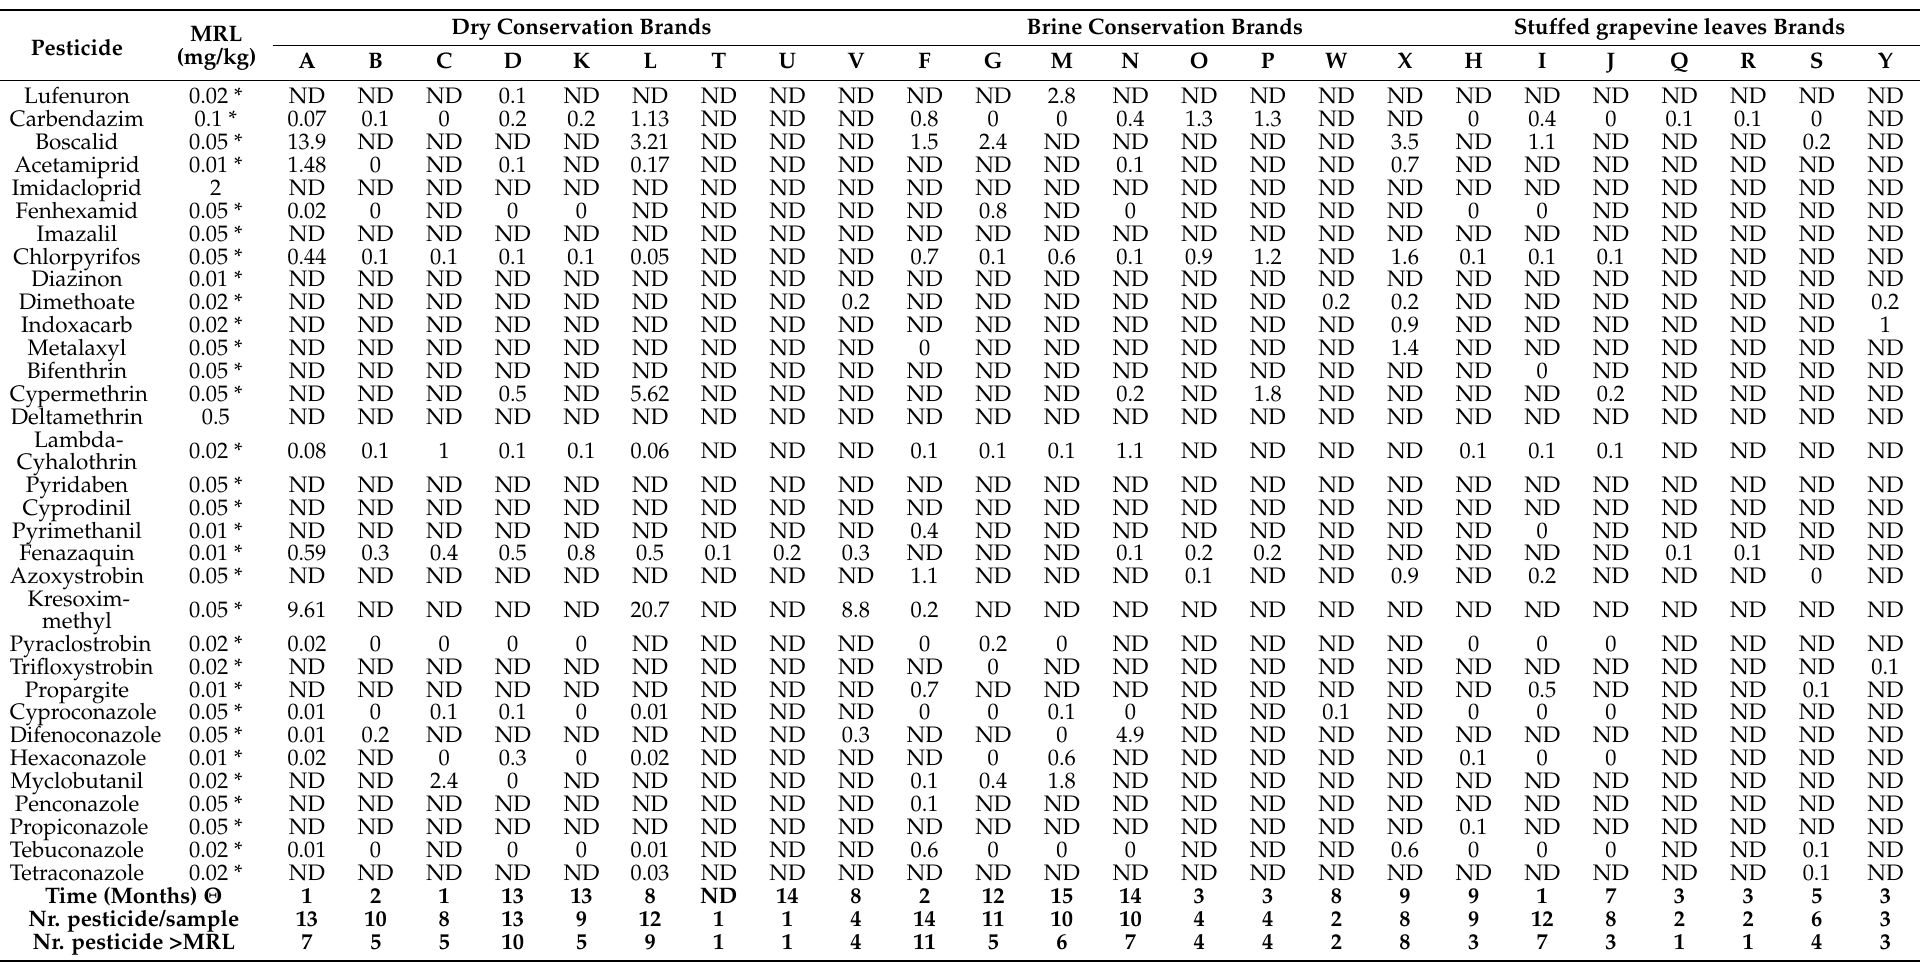
Table 2. Pesticide residue concentrations (mg/kg) for the dry, brine and stuffed preserved grapevine leaves market samples compared to EU-MRLs. Dry Conservation Brands Brine Conservation MRL Pesticide (mg/kg)